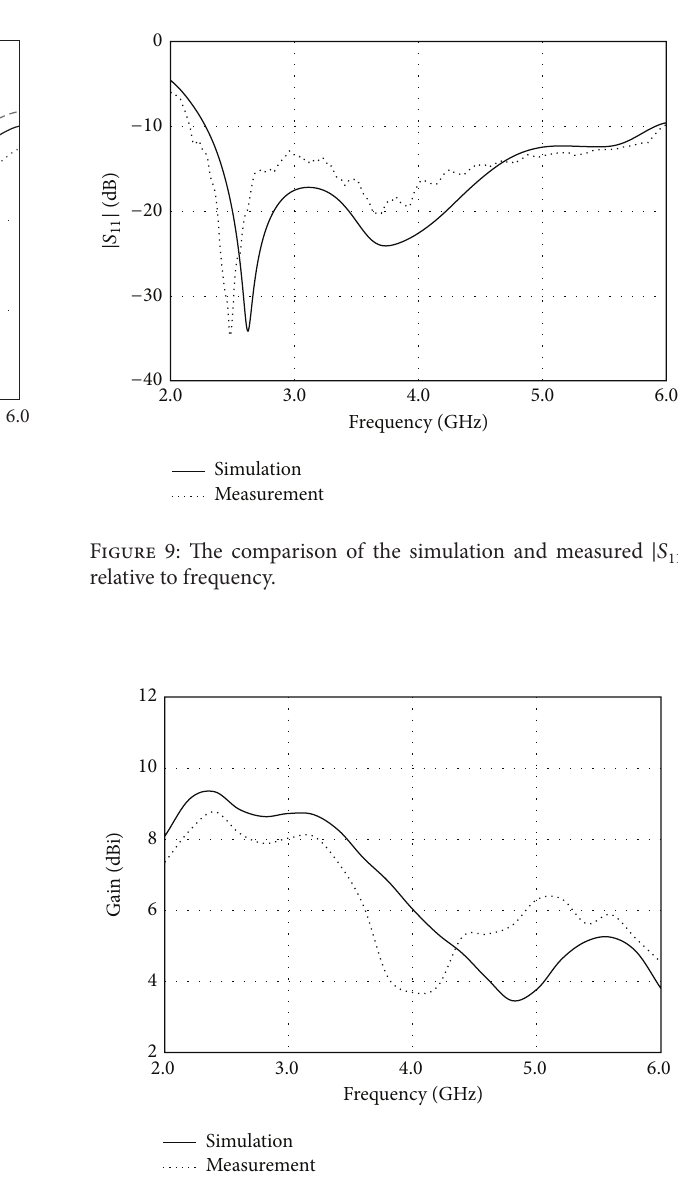
Figure 8: Photograph image of the prototype antenna.